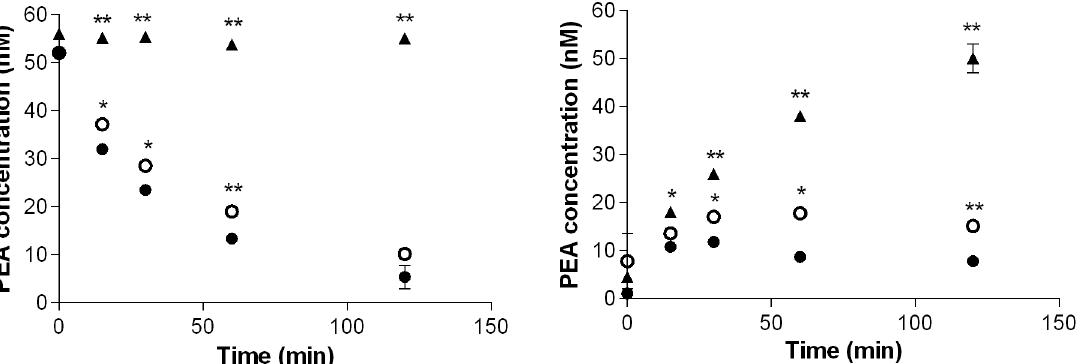
Fig 8. Role of amidase activity on compound degradation in rat liver homogenate. PEA levels in rat liver homogenate after addition of 50 nm PEA (left) or 50 nm L-Val-PEA prodrug (right) and pre-treatment with FAAH inhibitor URB597 at the final concentration of 100 nm ( (cid:2) ) and 10 μ m ( ▲ ), if compared to controls ( ● ); data are expressed as means ± SEM, n = 3. * P < 0.05; ** P <